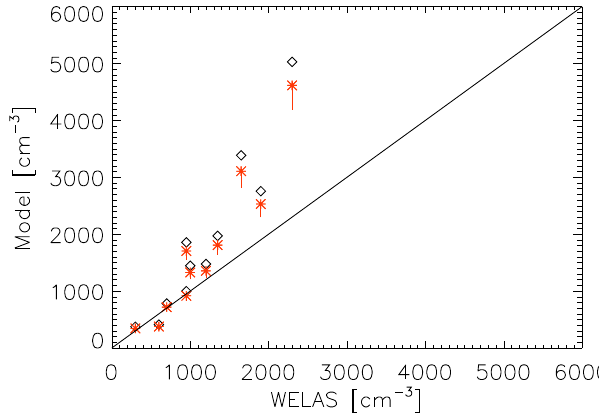
Figure 6. The number of cloud droplets formed in the model (or- ange stars) and the number of aerosol immediately before the ex- pansion (black diamonds), plotted against the maximum number of droplets detected by WELAS during the presence of the cloud. The error bars on the modelled droplet numbers correspond to simula- tions using the high and low values of the dew point calculated from the SIMONE data. Data are shown for all CLOUD9 experiments where data were